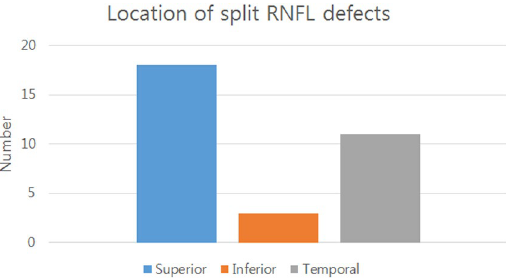
Figure 2. Split retinal nerve fiber layer (RNFL) defects developed most frequently in the superior region of the optic disc (n = 18), followed by the temporal region (n = 11). Split RNFL defects (n = 3) occurred less frequently in the inferior sector of the optic disc.